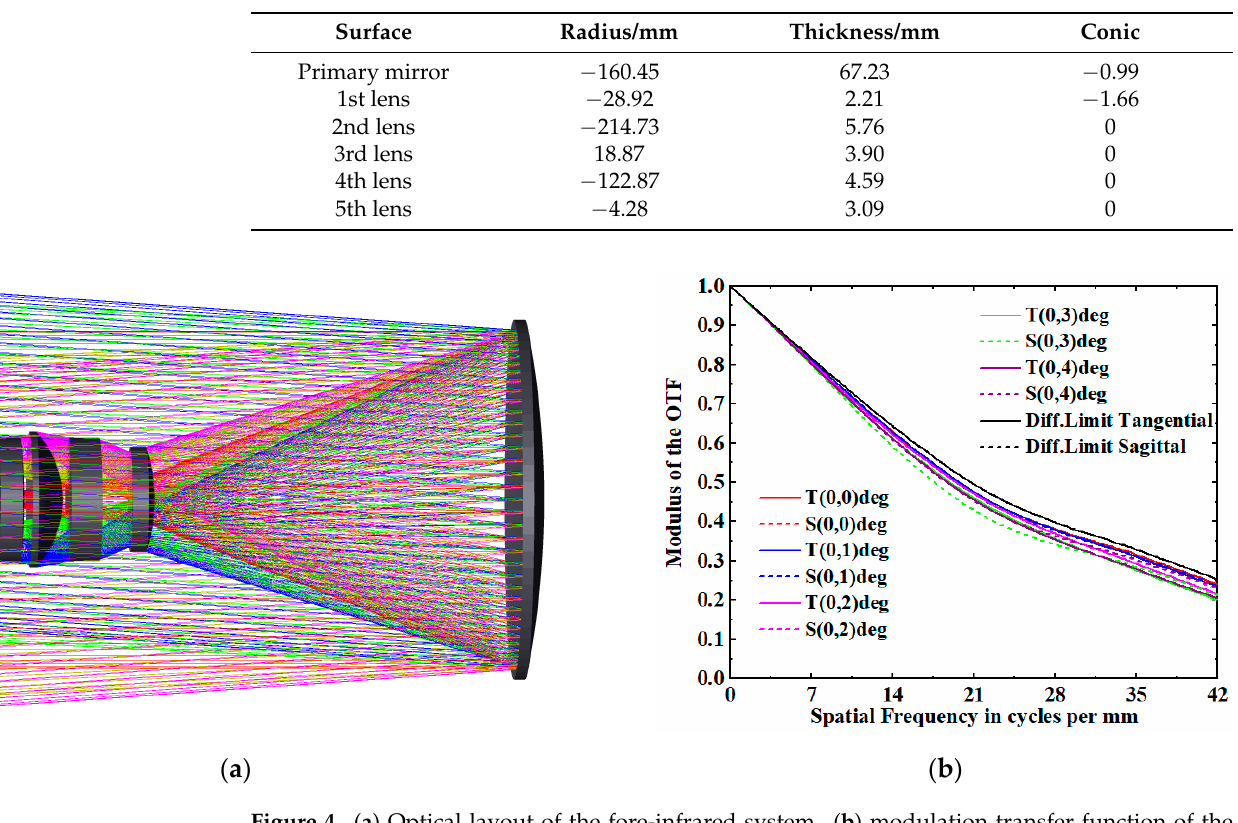
Table 2. Initial parameters of the fore-infrared system.